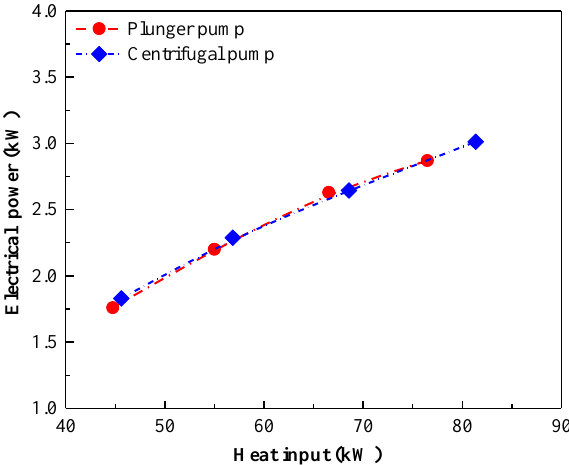
Figure 13. Electrical power with heat input using the plunger pump and centrifugal pump.